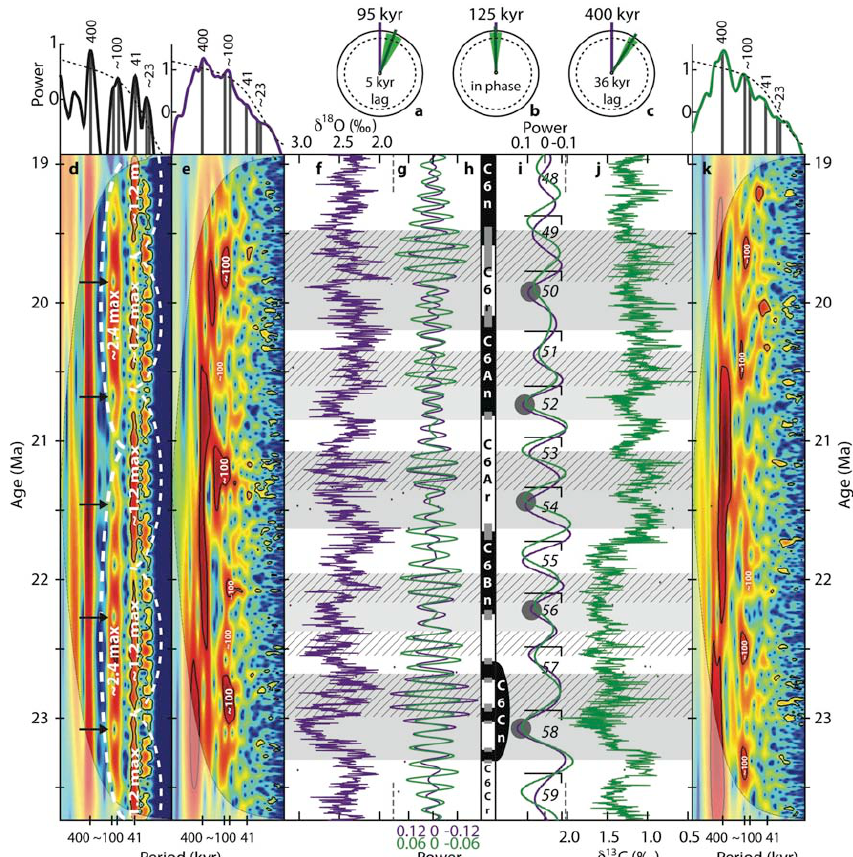
Fig. 5. Walvis Ridge (Site 1264) stable isotope records. Phase wheels represent the phase relation between δ 18 O (purple) and δ 13 C (green) at the (a) 95, (b) 125 and (c) 400kyr eccentricity periods, where 360 ◦ represents one full cycle. Phase lags increase clockwise and the green areas represent the 95% confidence level. Vector length shows coherency (dashed circle 95%). (d) Wavelet analysis (Grinsted et al., 2004) with > 95% confidence levels (black lines) of an eccentricity/obliquity/precession mix calculated after the Laskar et al. (2004) astronomical solution. Time step size after re-sampling is 2.75kyr. White dashed lines indicate the (on average) ∼ 1.2 and ∼ 2.4Myr amplitude modulation of obliquity and eccentricity. Arrows indicate minima in 400kyr eccentricity (characterized by a smaller amplitude 100kyr cycle) that coincide with maximum ice-sheet expansion. These minima are timed 1 × , 2 × or 4 × 400kyr apart. On top the global spectrum (Torrence and Compo, 1998) with > 95% confidence level. (e) Wavelet analysis and global spectrum – processed as in panel (d) – of δ 18 O record after removal of > 0.5Myr periodicities using a notch filter (Paillard et al., 1996) ( f :0.0, bw:2.0) and normalization. (f) Oxygen isotope ( δ 18 O+0.64‰) record from Site 1264. Loose dots represent outliers. (g) Gaussian filters (Paillard et al., 1996) ( ∼ 100kyr, f : 10.0, bw: 2.0) of the δ 18 O (purple) and δ 13 C (green) records. (h) Transferred magnetostratigraphy (Bowles, 2006) from Site 1265 to Site 1264. Black is normal, white is reversed, gray is uncertain. (i) Gaussian filters (Paillard et al., 1996) (400kyr, f : 2.5, bw: 1.0) of the δ 18 O (purple) and δ 13 C (green) records, with corresponding 400kyr cycle numbers (Wade and P¨alike, 2004). Gray circles mark maxima of the ice-sheet expansion phases. (j) Carbon isotope ( δ 13 C) record from Site 1264. Loose dots represent outliers. (k) Wavelet analysis and global spectrum of δ 13 C – processed as in panel